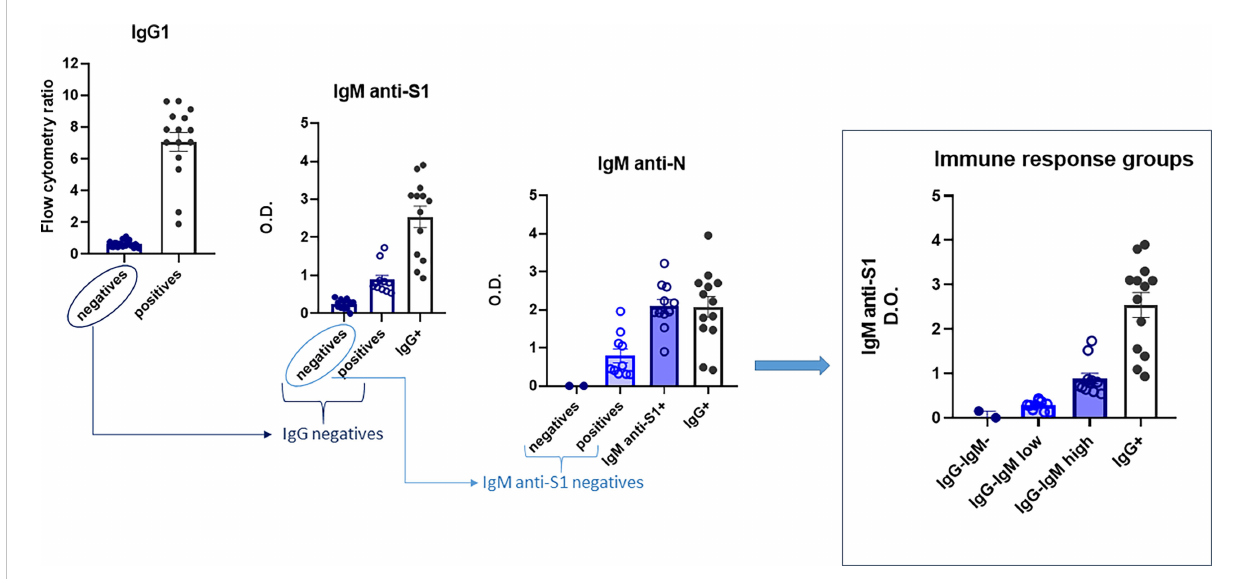
FIGURE 1 Flowchart of the immunoglobulin pro fi le in children to evaluate their immunological status. Four groups were fi nally de fi ned: IgG − IgM − , IgG − IgM low , IgG − IgM high , and IgG + . Sera were analyzed as described in the Material and methods . Results shown are the mean values of one duplicate experiment of the three independent experiments performed with similar qualitative